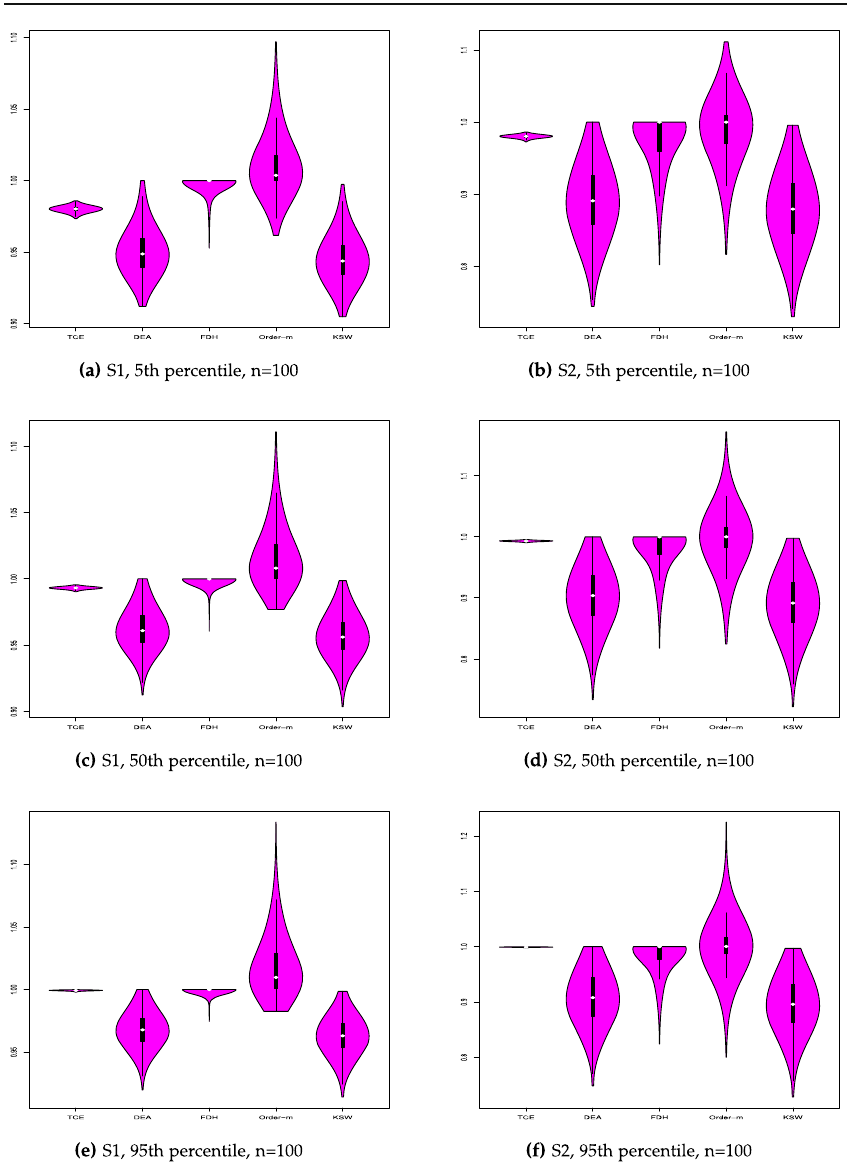
Fig.1 Violin plots in scenario 1 and 2 for 5th, 50th, and 95th percentiles of cost efficiency estimates under a Cobb-Douglas cost function because the TCE distribution is highly dispersed and therefore better represents the estimators’ performance. At the 5th and 50th percentiles, DEA and KSW densities are very close to the true distribution of efficiency, while FDH and order- m overestimate it. In contrast, at the 95th percentile FDH seems to be closer to the TCE although it slightly overestimates